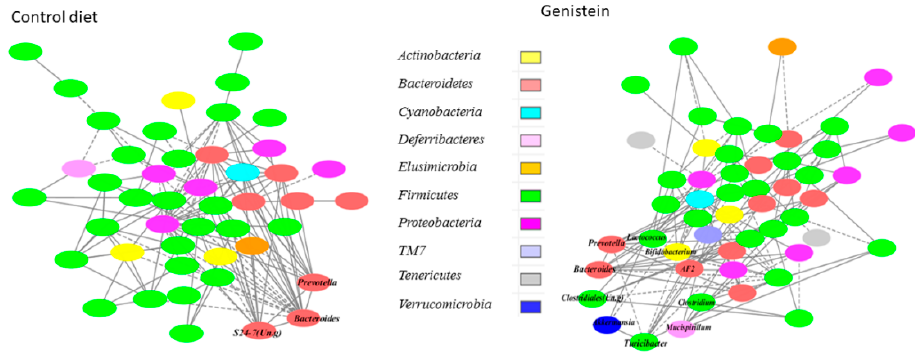
Figure 6. Effect of genistein (GEN) supplementation on microbial interaction networks inferred using the SparCC algorithm. Solid line: positive correlation; dashed line: negative correlation. The color of each node (genus) represents the phylum to which this genus is assigned.